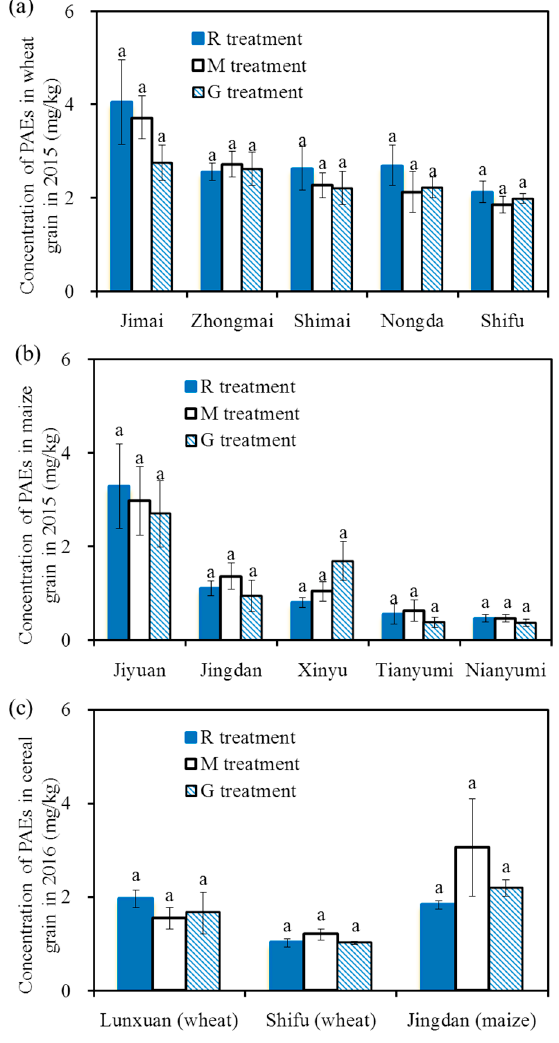
Figure 5. Concentrations of the 6 PAEs in cereal grains in 2015 and 2016, concentrations of the 6 PAEs in winter wheat grain in 2015 ( a ); concentrations of the 6 PAEs in summer maize grain in 2015 ( b ); concentrations of the 6 PAEs in winter wheat and summer maize grain in 2016 ( c ). Note: Different letters on the top of the histogram indicate significant differences among the three treatments for each variety ( p < 0.05).